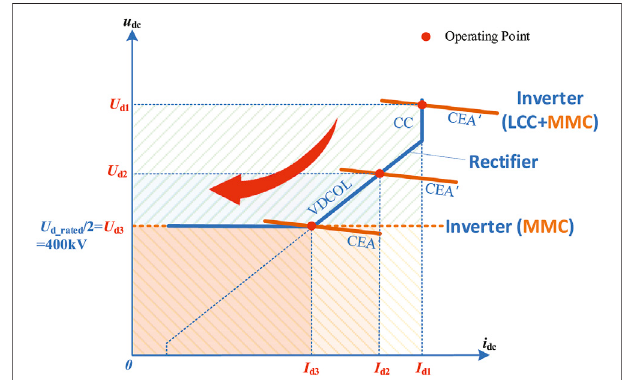
FIGURE 5 | Transient characteristic when AC fault happens at inverter side.